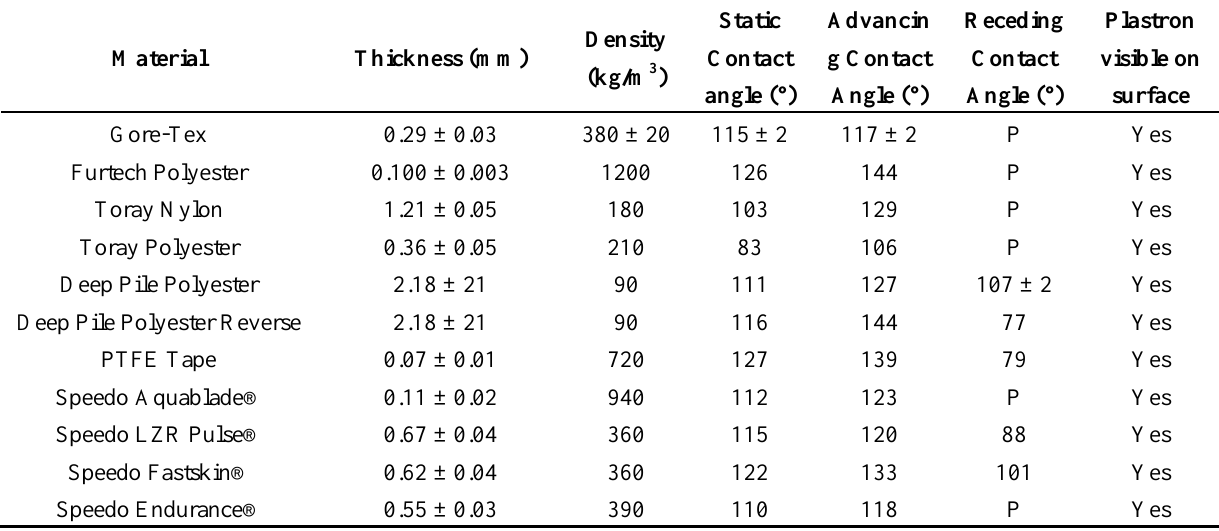
Table 1. Measurements of the static, advancing and receding contact angles and the contact angle hysteresis for the materials used in the study. P in the receding contact angle column denotes that the water was pinned to the surface of the material. The thickness and densities of each fabric are also